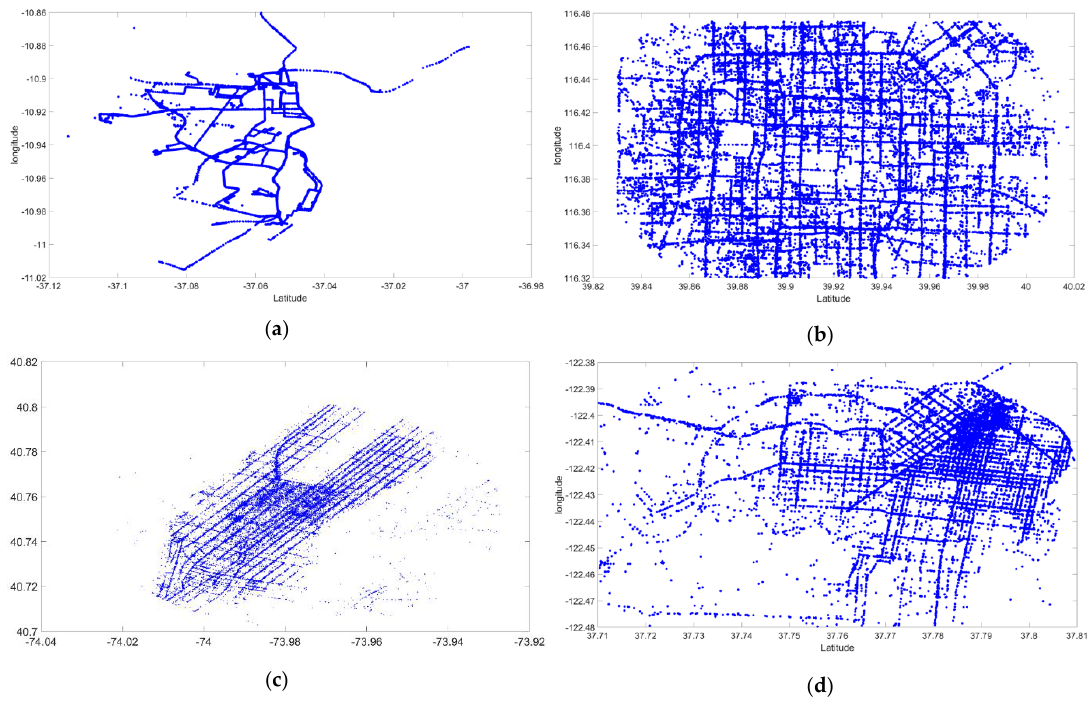
Figure 2. Distribution of Origins and Destinations (OD) of taxi GPS data: ( a ) Aracaju (Brazil); ( b ) Beijing (China); ( c ) New York (USA); and ( d ) San Francisco (USA).